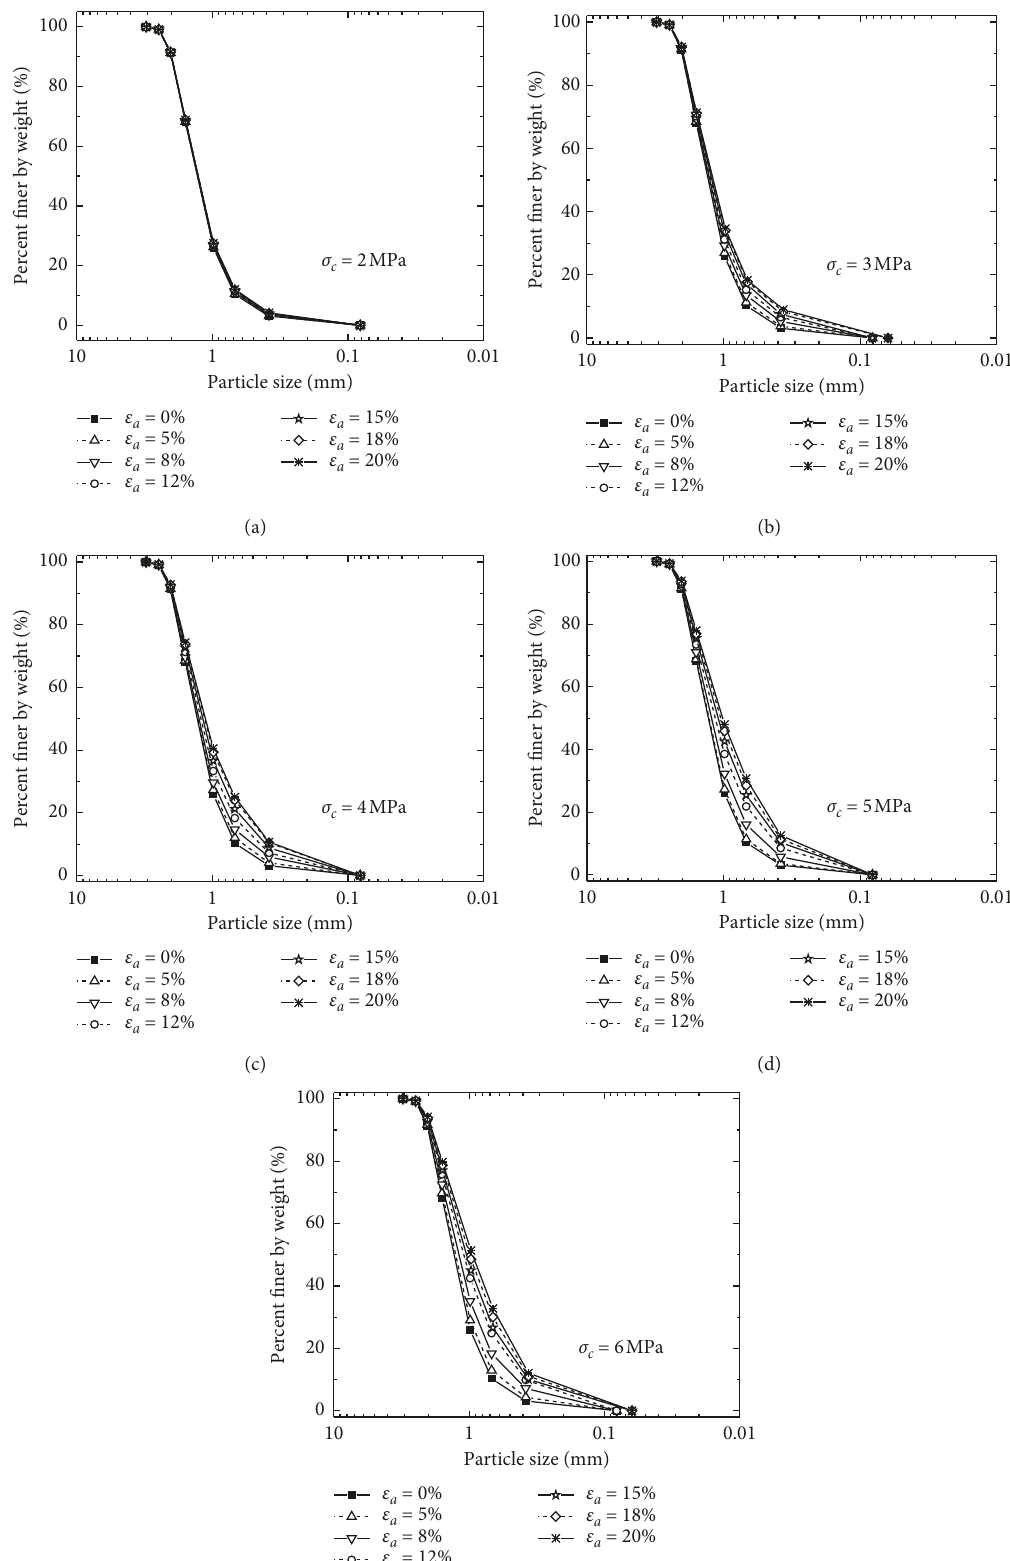
Figure 14: Particle size distribution curves of numerical samples during shearing. (a) σ σ c � 5 MPa. (e) σ c � 6